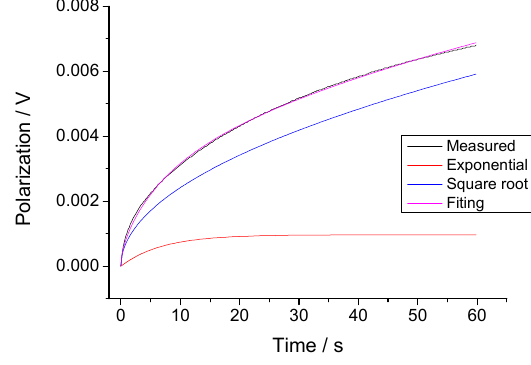
Figure 3. Fitting of the polarization curve of ISE 2 in 0.01 M KNO 3 .